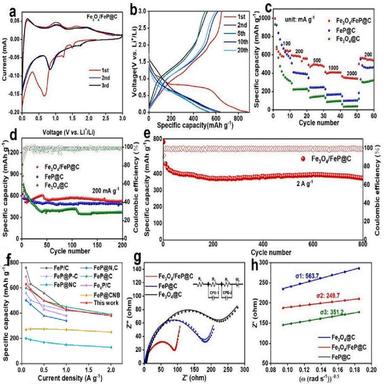
(a) CV curves of Fe3O4/FeP@C. (b) First 20 cycles galvanostatic charge/discharge curves of Fe3O4/FeP@C. (c) Rate capability and (d) cyclic performance of Fe3O4/FeP@C, FeP@C, and Fe3O4@C. (e) Cyclic performances of Fe3O4/FeP@C. (f) Comparison of rate capabilities between Fe3O4/FeP@C and the reported FeP based anodes. (g) Nyquist impedance plots and (h) relationship between Z′ and ω− 1/2.